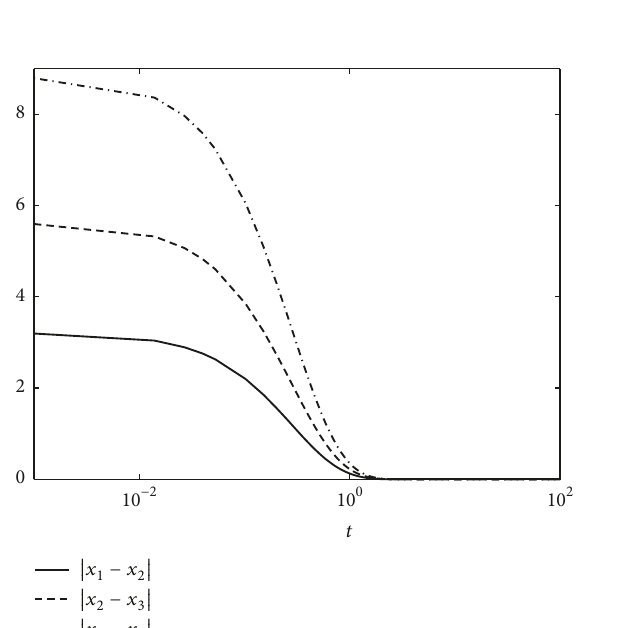
Figure 5: Linear case, 𝑗 = 4 .